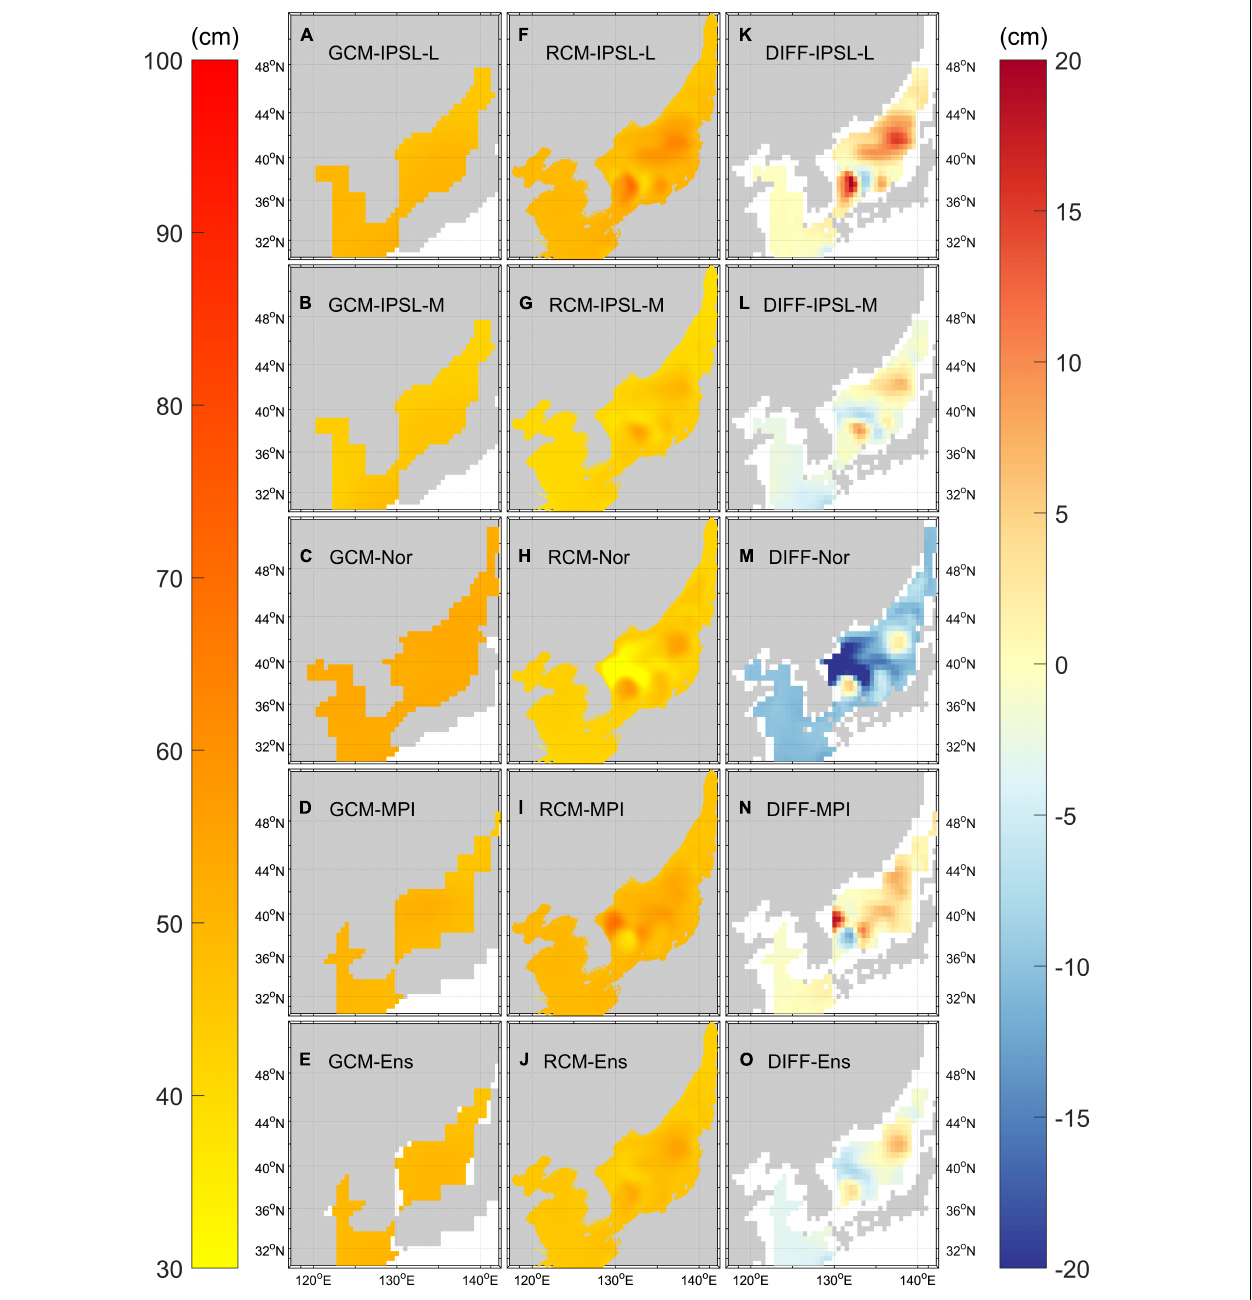
FIGURE 9 | Sea-level rise (unit: cm) between 1986–2005 and 2081–2100 in the NWP marginal seas under RCP 4.5 scenario according to panels (A–D) GCMs, and (F–I) RCMs. (E) and (J) represent the ensemble means of the GCMs and RCMs, respectively. Differences between the two modeling methods (RCM-GCM) are shown in panels (K–O)